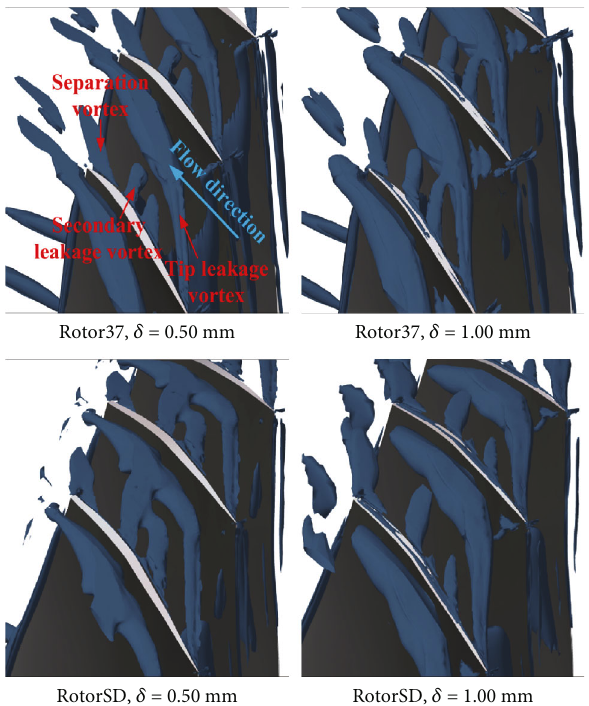
Figure 14: Tip vortex structure ( Q = 9 × 10 7